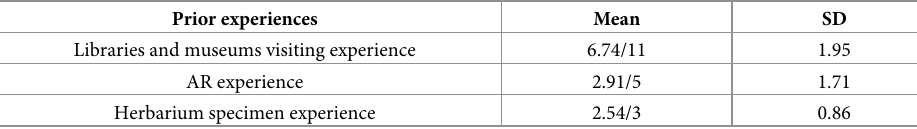
Table 3. Prior experience of participants (N =